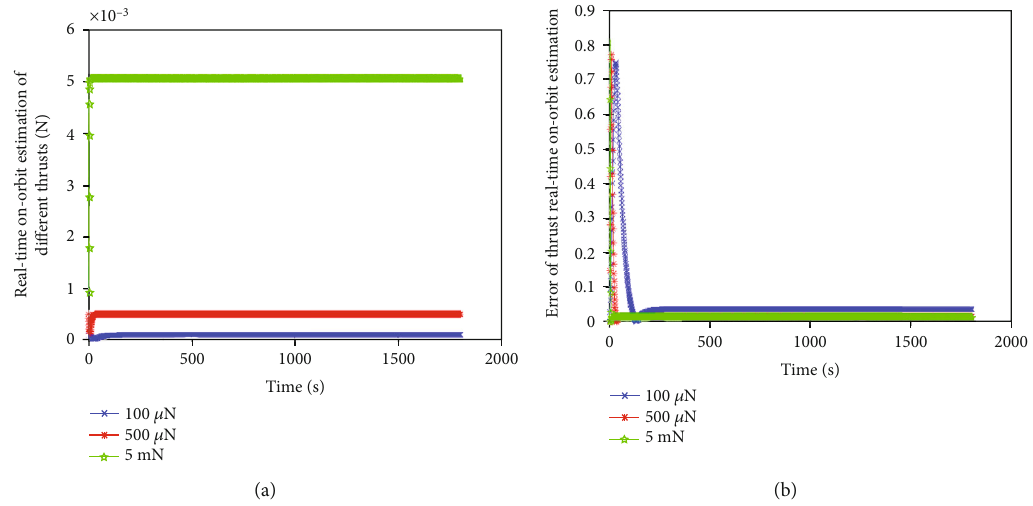
Figure 11: Real-time on-orbit estimates and errors for di ff erent